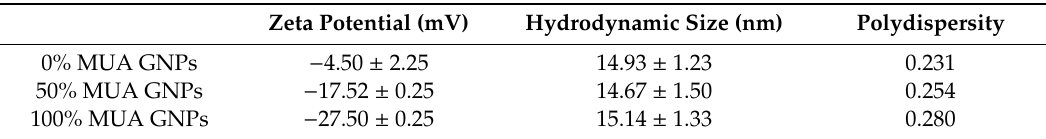
Table 1. The Zeta potential and hydrodynamic size of the three GNPs. (Error ranges represent standard error of the means).